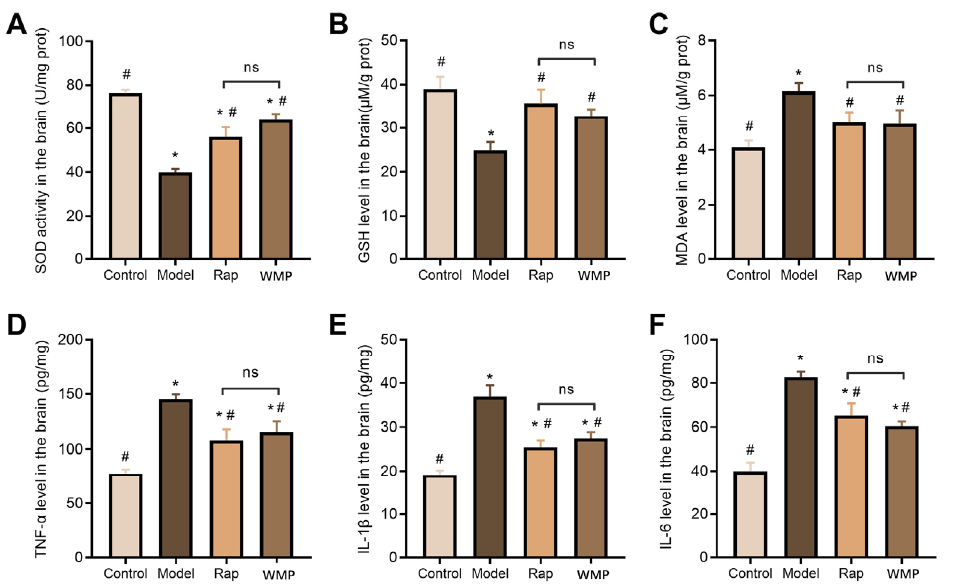
Figure 4. The effects of WMP on the antioxidant index and inflammatory cytokine in the brain. ( A – C ) SOD activity, GSH and MDA levels, respectively, ( D – F ) the levels of TNF- α , IL-1 β and IL-6, re- spectively. * p < 0.05 vs control group and # p < 0.05 vs model group; ns: not significant.